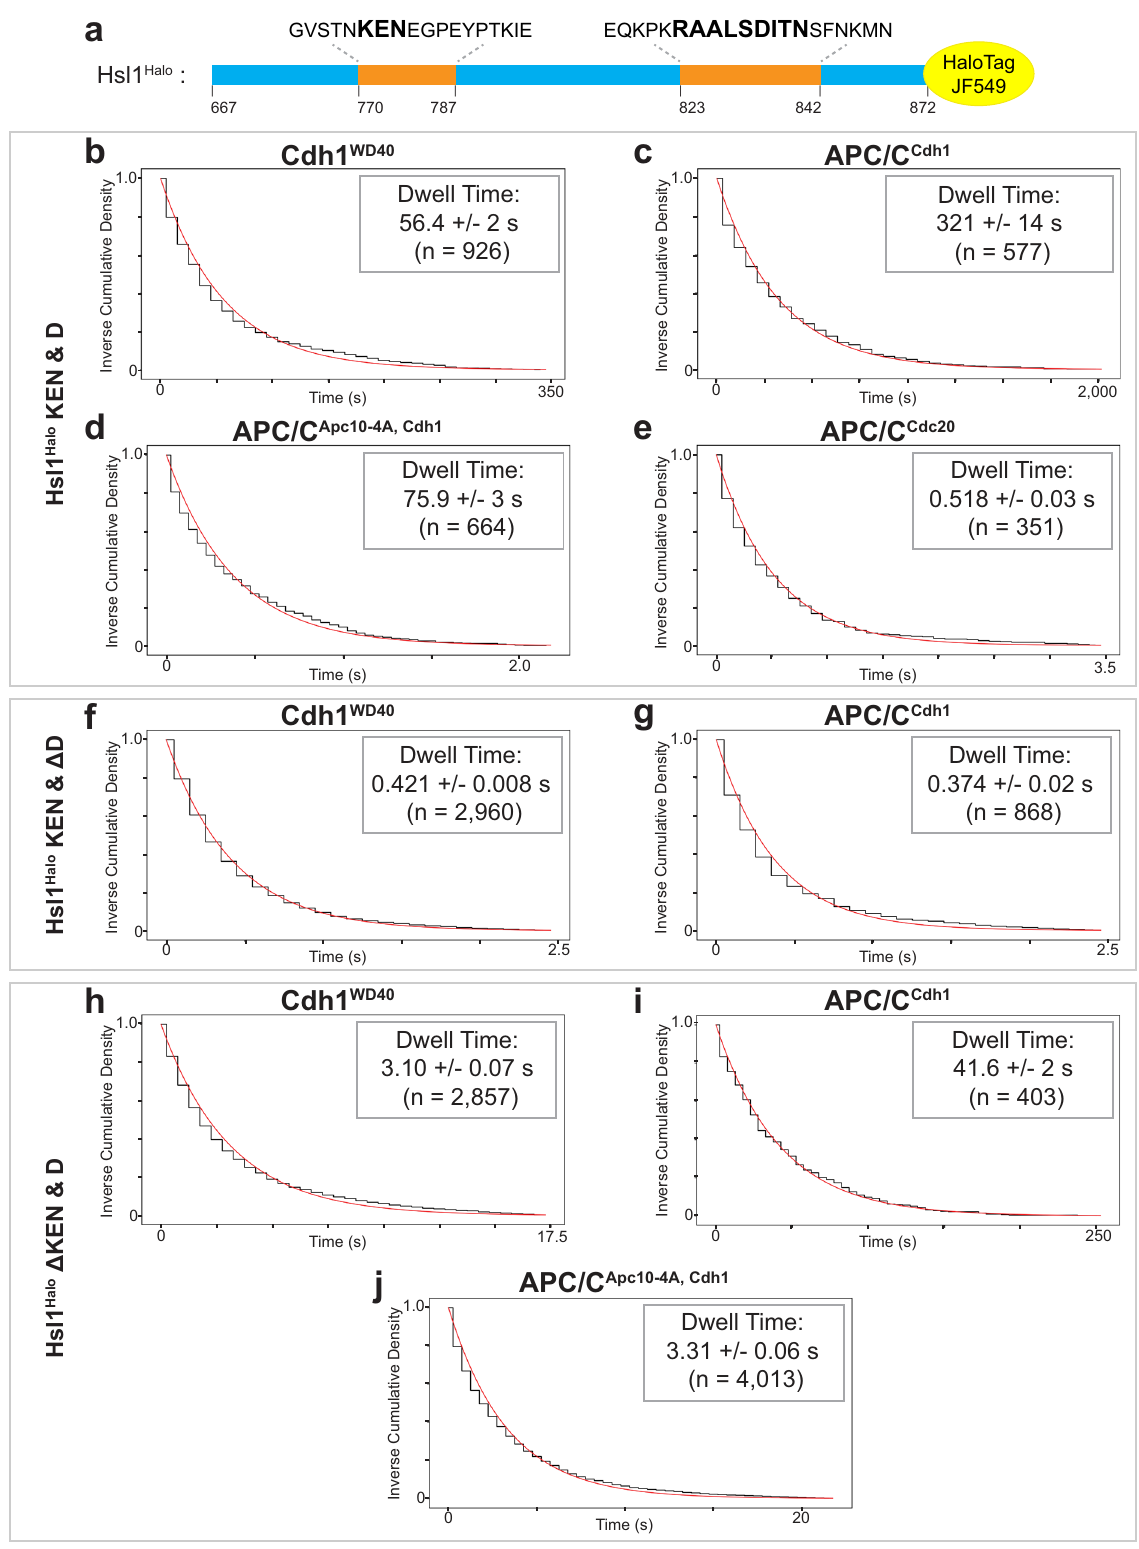
Fig. 6 Double degron substrate interactions. a Hsl1 Halo fragment used in these experiments, showing sequences of KEN and D boxes. b – e Dwell time distributions from SMOR analysis of representative movies with Hsl1 Halo carrying wild-type degrons and the indicated GFP-tagged binding proteins: b Cdh1 WD40 ; c APC/C Cdh1 ; d APC/C Cdh1 with Apc10-4A mutations; e APC/C Cdc20 . f – g Analysis of Hsl1 Halo with mutant D box, binding to: f Cdh1 WD40 ; g APC/C Cdh1 . h – j Analysis of Hsl1 Halo with mutant KEN, binding to: h Cdh1 WD40 ; i APC/C Cdh1 ; j APC/C Cdh1 with Apc10-4A mutations. Insets indicate mean dwell time ± SE ( n indicates number of selected peaks). Results are representative of two independent experiments (Supplementary Table